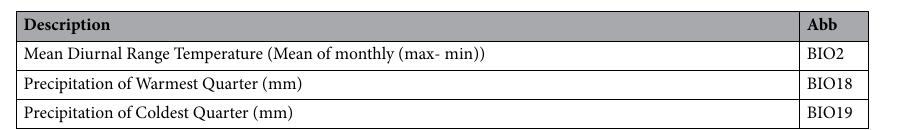
Table 1. Selected environmental variables from PCA groups. Abb: Abbreviation from Worldclime 57